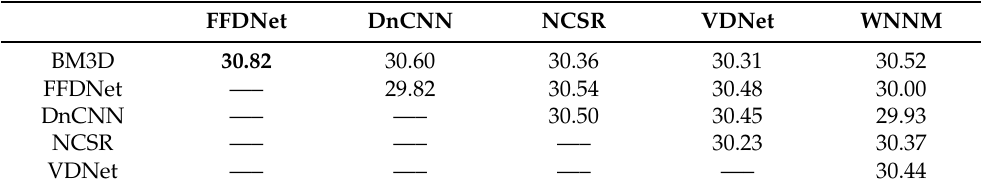
Table 1. Average performance of various combinations on 10 commonly used images with noise level 30.